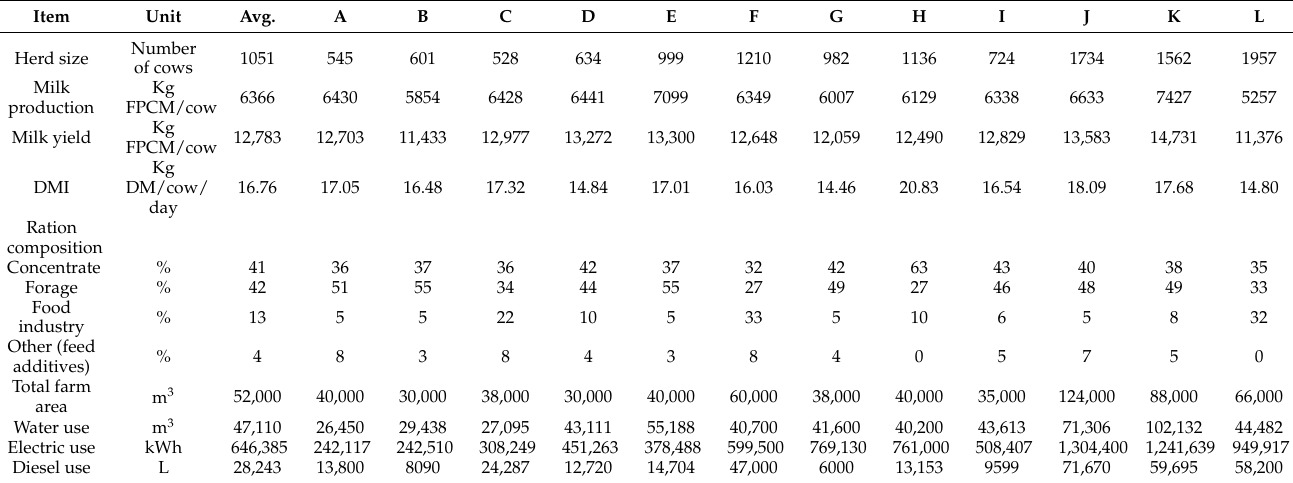
Table 1. Primary data for the participating dairy farms (per